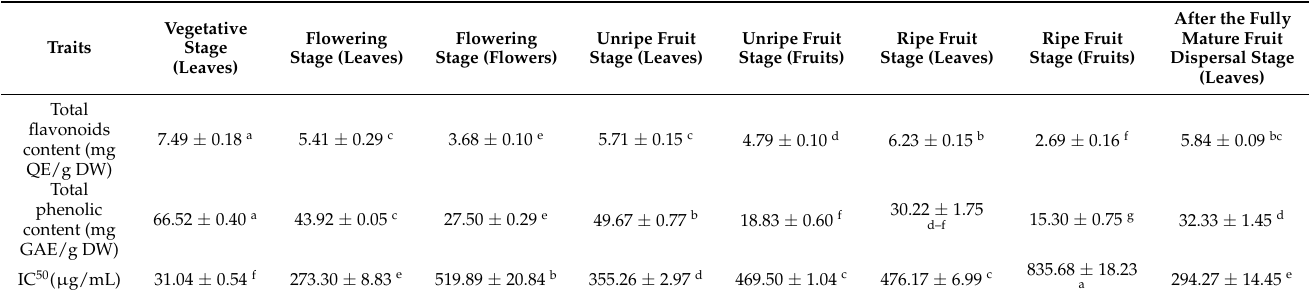
Table 2. Contents of total phenols and flavonoids and antioxidant activity of different myrtle organs in different phenological